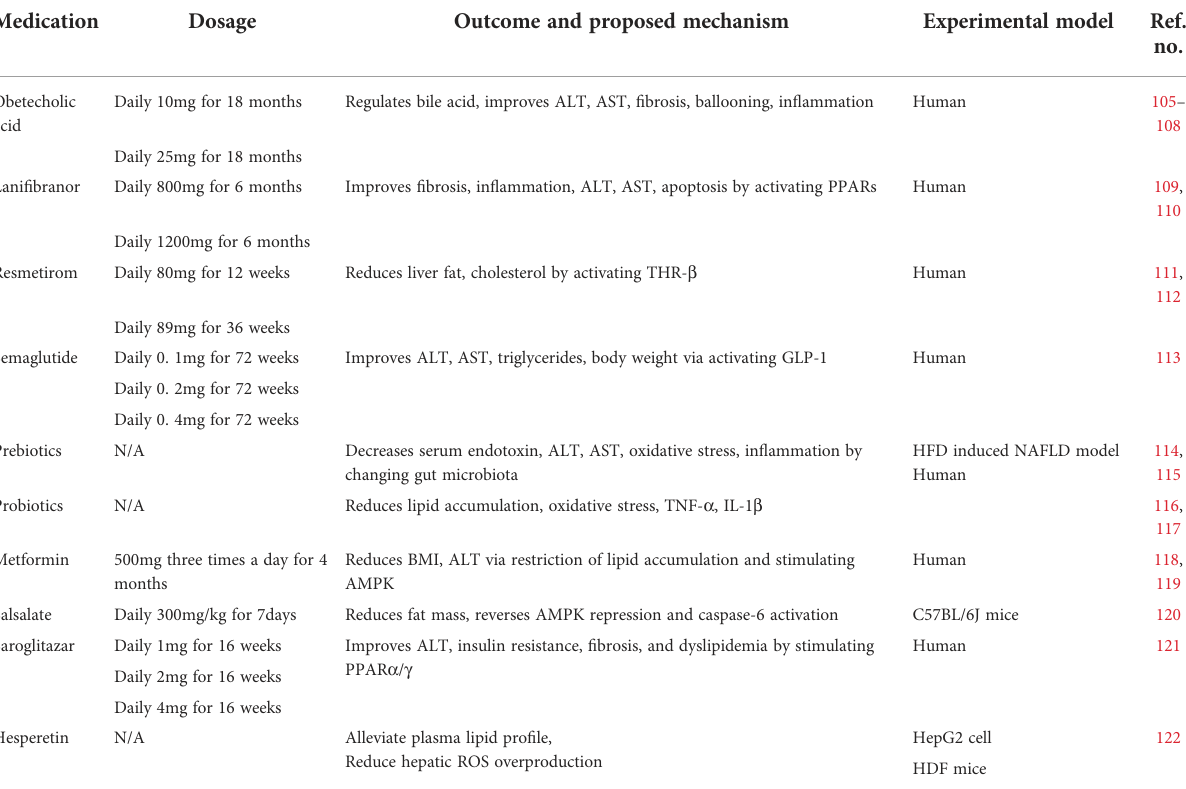
TABLE 1 Medications